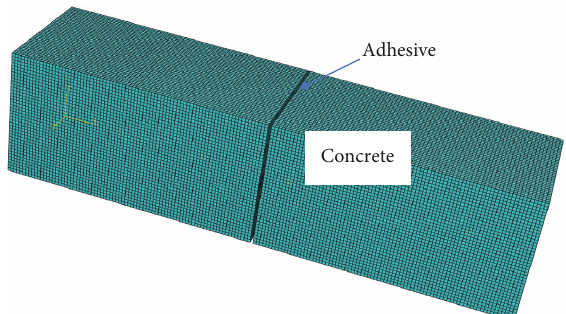
Figure 3: 3-dimensional geometrical model of the sandwiched four-point bending